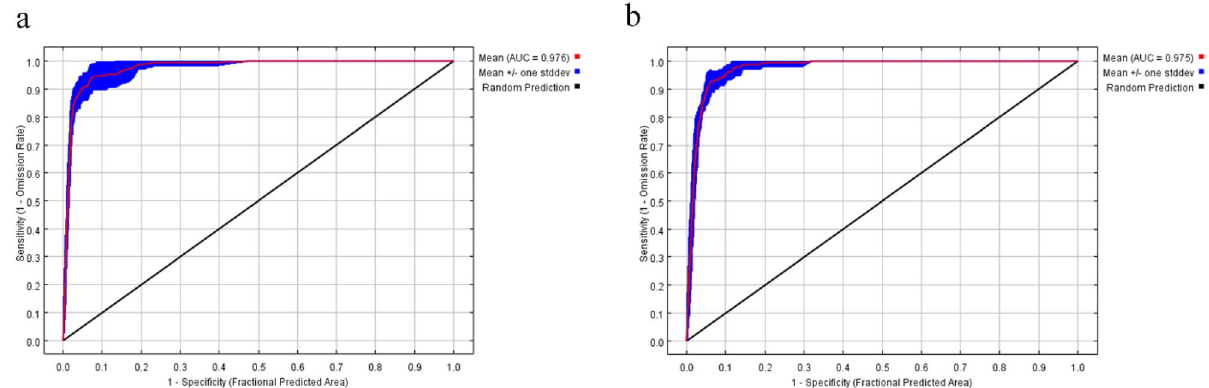
Figure 3. Receiver operating characteristics (ROC) curves and area under the curve (AUC) values of the MaxEnt models: ( a ) O. monoceros ; ( b ) O. rhinoceros .